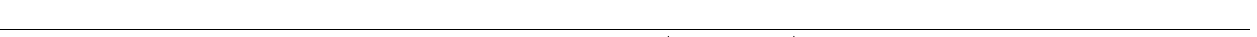
Fig. 2 The effect of DENV2-immune sera on ZIKV infection in vitro and in Ifnar1 − / − mice. Ifnar1 − / − mice were immunized intraperitoneally with DENV2 (2 × 10 2 FFU) for 28 days. Naive Ifnar1 − / − mouse sera ( n = 10) and DENV2-immune Ifnar1 − / − mouse sera ( n = 10) were examined for their ability to neutralize DENV2 or ZIKV using U937 DC-SIGN cells and a fl ow cytometry-based neutralization assay ( a ). Data were pooled from two independent experiments with n = 5 mouse sera per group and expressed as mean ± SEM. Different volumes of naive and DENV2-immune Ifnar1 − / − mouse sera were passively transferred (retro-orbital route) to naive recipient Ifnar1 − / − mice ( b , c ). Three days post retro-orbital challenge with 1 × 10 4 FFU of ZIKV FSS13025, viral burdens in sera and indicated organs were measured using FFA. In b , data are pooled from two independent experiments ( n = 3 – 4 mice per group per experiment), while results in c represent one experiment. Data are expressed as mean ± SEM. ** p < 0.01. b A Kruskal – Wallis one-way ANOVA. c Two-tailed Mann – Whitney test. Supplementary Tables 1 and 2 provide exact values of n and